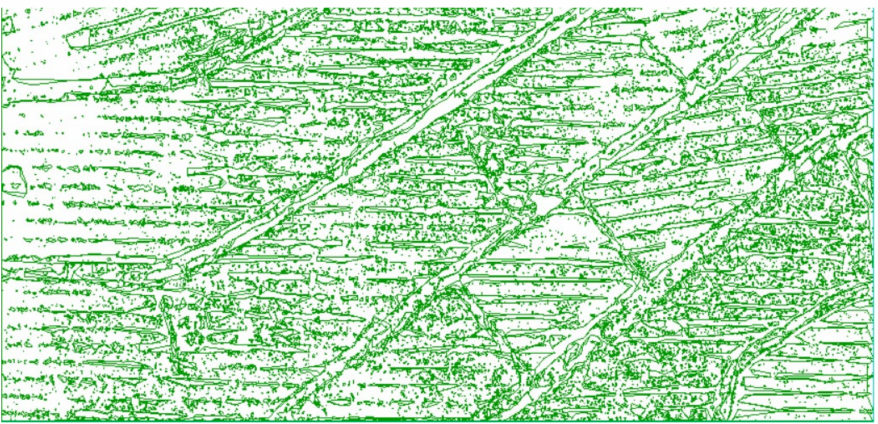
Figure 7. Sample graph of the object-oriented image segmentation.